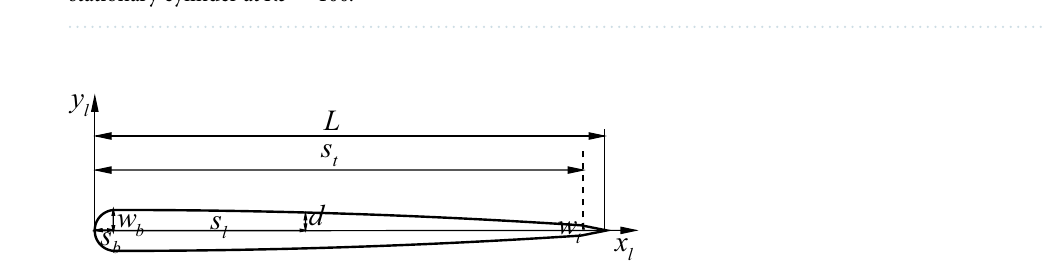
Table 1. Comparison of mean drag coefficient and peak-to-peak lift coefficient for a uniform flow over a stationary cylinder at Re = 100 .